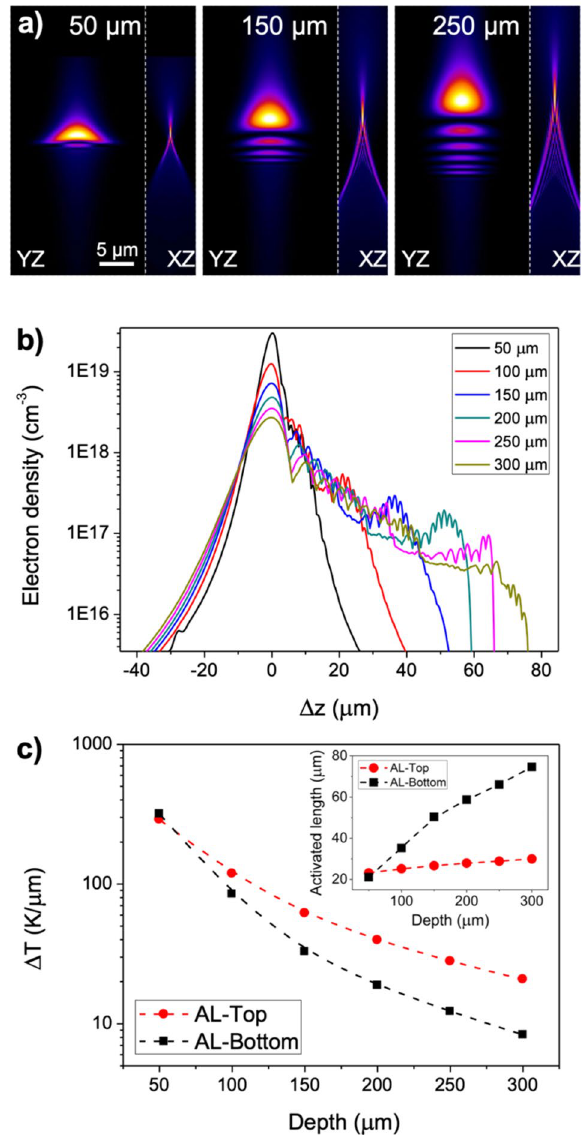
Figure 4. ( a ) Beam intensity for AL lens along XZ and YZ planes for the labeled focusing depths. ( b ) Electron density profiles for the labeled focusing depths. Spectra are horizontally shifted so the maximum electron density is at 0 for all the cases. ( c ) Temperature gradient (main graph) and activated length (inset) versus the focusing